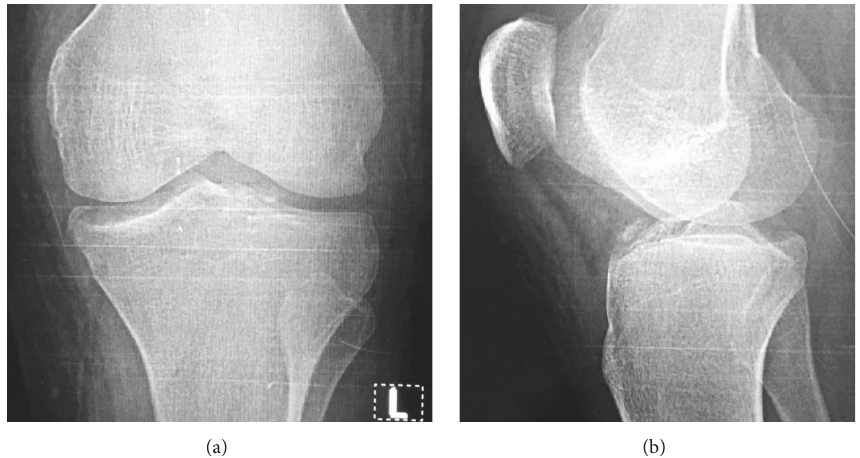
Figure 4: Anteroposterior (a) and lateral (b) postoperative radiographs. Medial and anteromedial rim fractures were repaired using nonabsorbable transosseous sutures. Tibial attachment of ACL was reduced and fixed in place using pullout